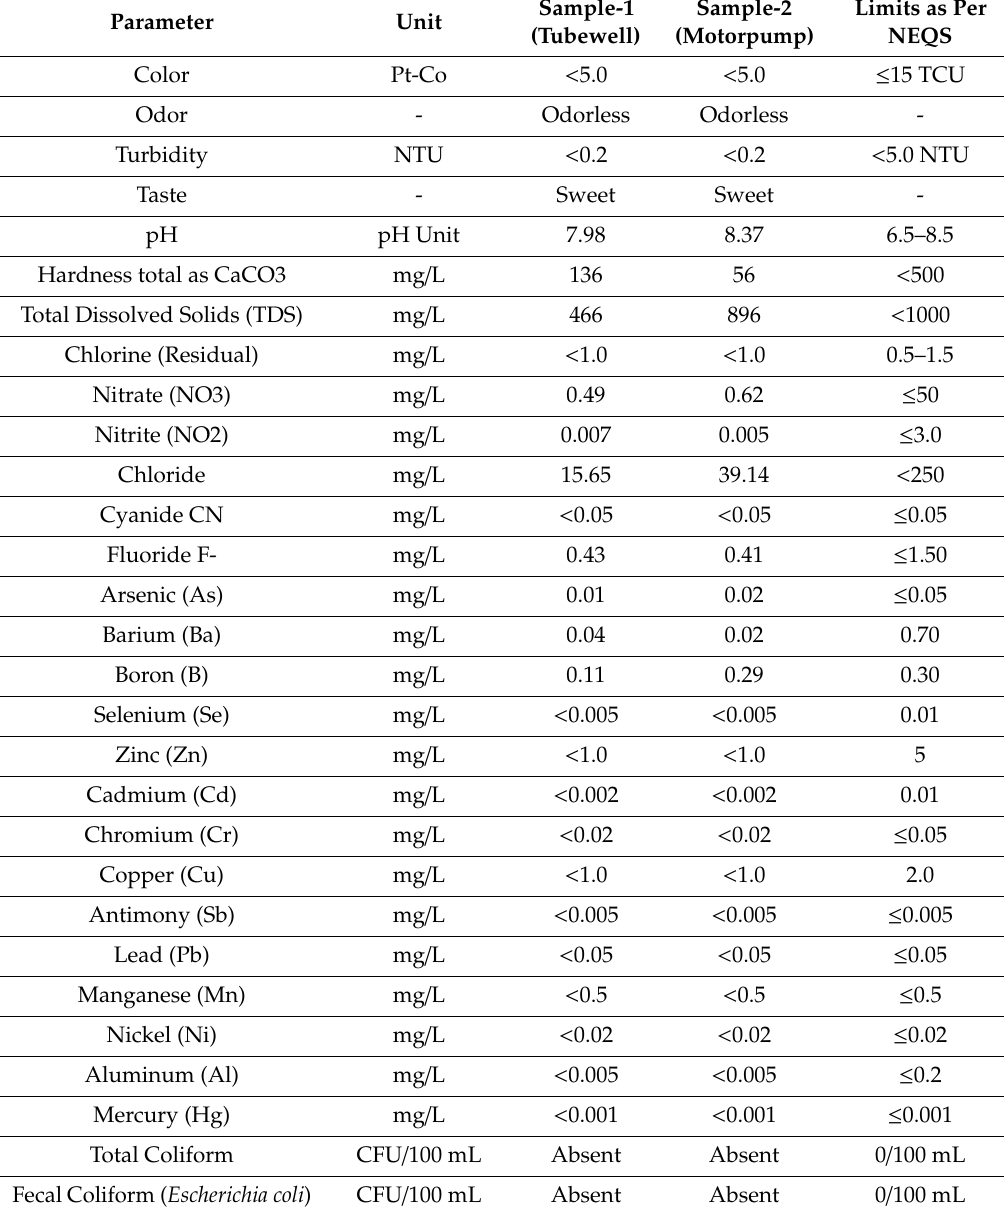
Table 2. Drinking water quality in the vicinity of Gaddafi Stadium